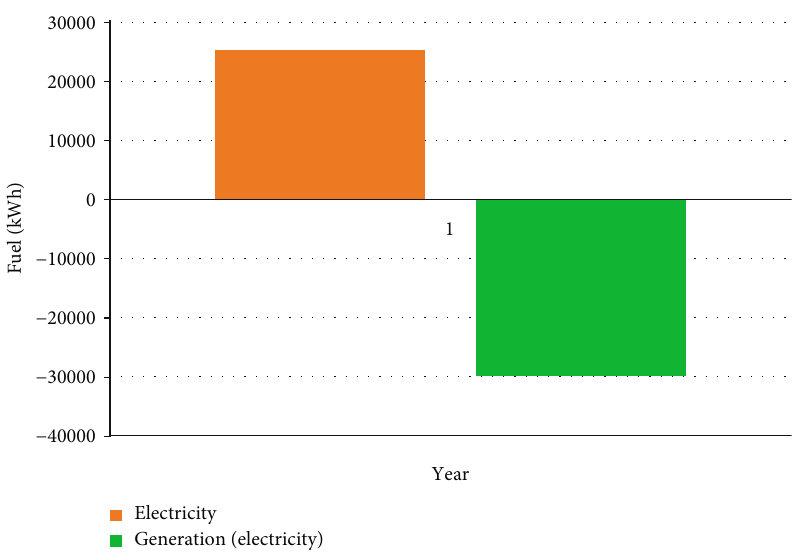
Figure 16: Total annual consumed and produced energies using renewable energies of the